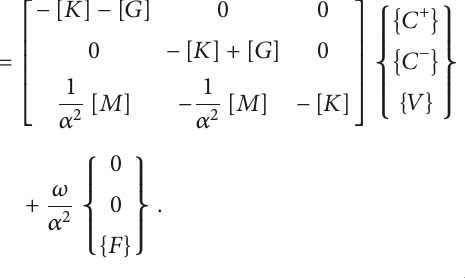
/𝐷 ratio = 2 ). concrete coating